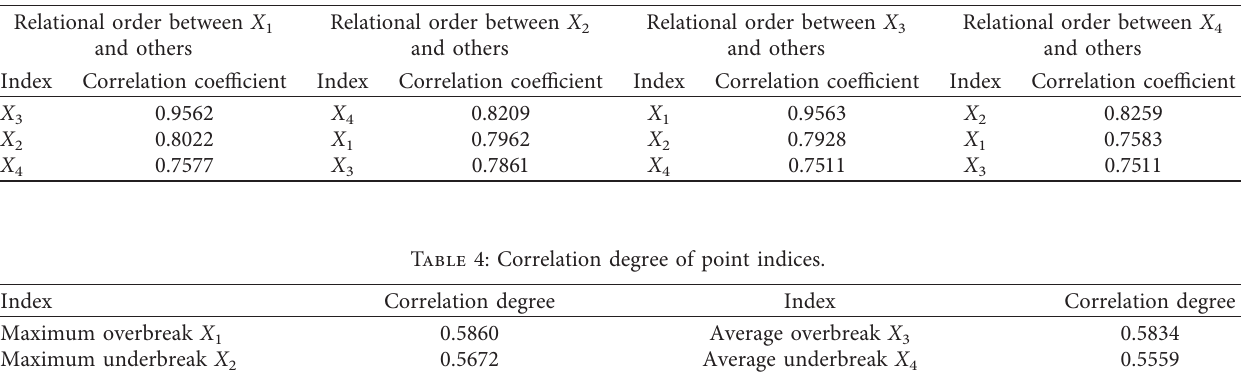
Table 3: Relational order of point indices.